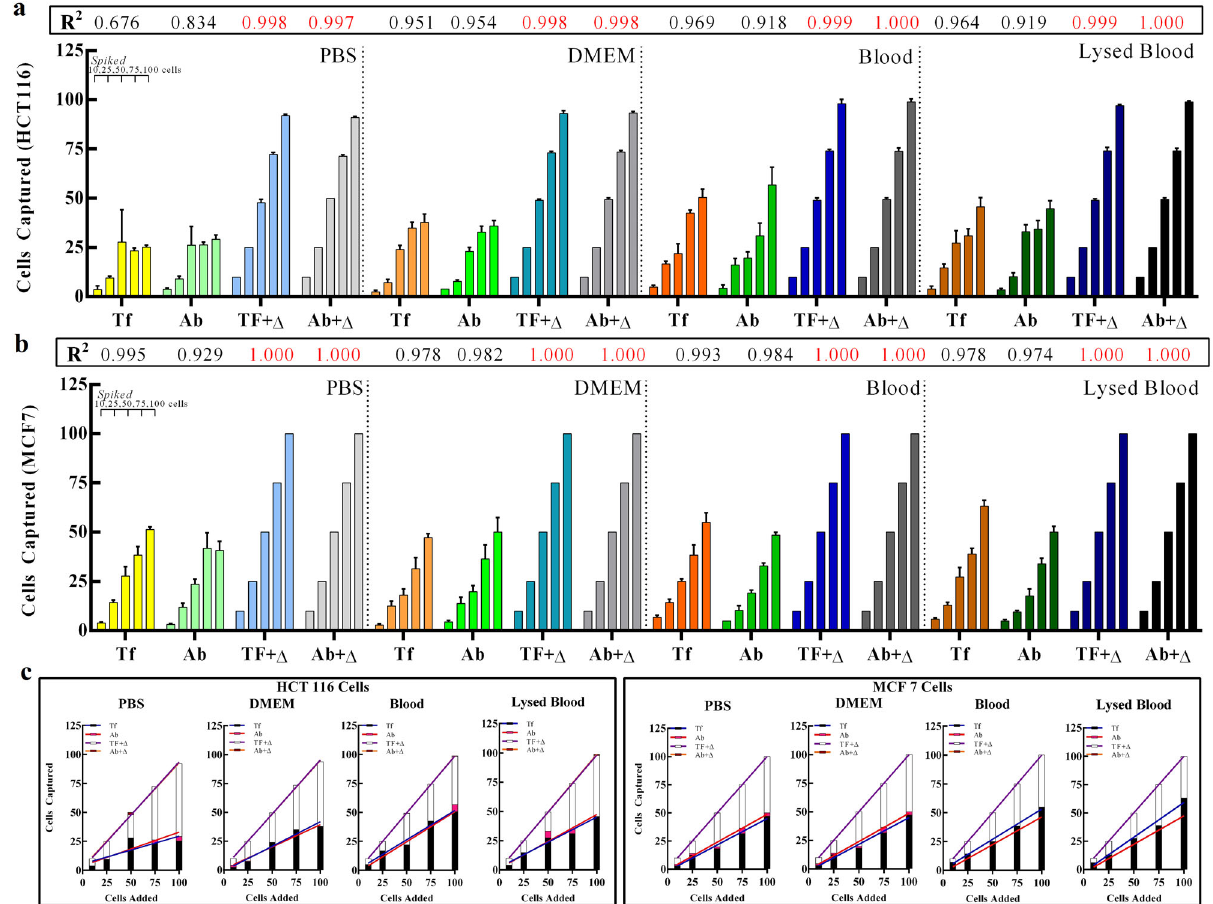
Fig. 5 Capture ef fi ciencies of MFNs in the presence of NaHCO 3 compared to controls. a Grouped plots of HCT 116 cell capture by the two MFNs under control conditions and in the presence of NaHCO 3 , denoted by Δ . The MFNs are treated with four media, PBS, DMEM, Blood and Lysed Blood (simulated serum) as reported here. The MFNs are further exposed to incremental quantities of spiked HCT 116 cells in an identical manner across all treatments, as indicated by the addition bar (10, 25, 50, 75, 100 cells) depicted in the top left of the plot area. b Depicts a similar experimental outcome using MCF7 cells under identical conditions. Data is reported as mean ± SD cells with correlation of group data represented as R 2 above individual plots. c Linear regression treatment of the data shown in a and b ; HCT116 cell capture trials displayed in the left panel depicts treatments with and without the added NaHCO 3 resulting in two grouped correlation with a very high degree of linearity ( ‘ goodness of fi t ’ , R 2 > 0.676). The panel for MCF7 cells (right) also depict a similar outcome with more pronounced linearity ( R 2 > 0.929). The p values for statistical comparison were calculated as being less than 0.05 across the entire treatment panel for both cell